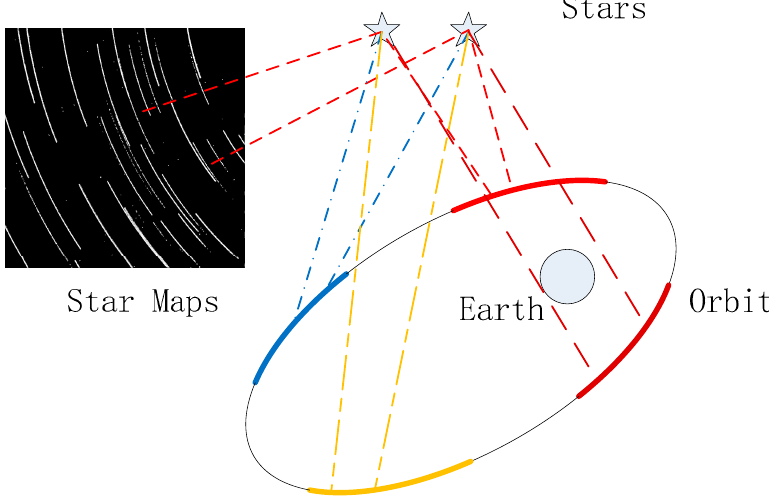
Figure 4. Reasons for ambiguous solutions.